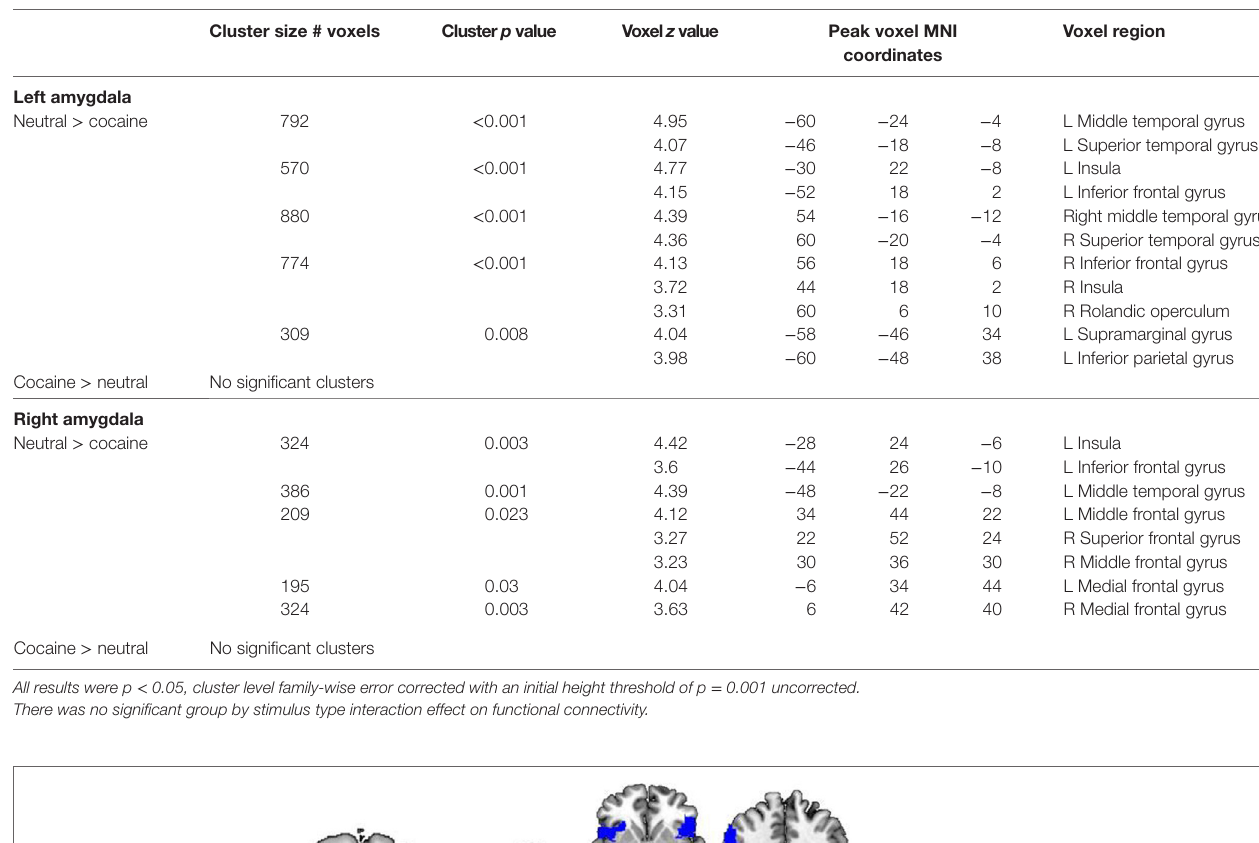
and middle temporal cortex. No such effects were evident for functional connectivity with the right amygdala as a seed region ( Table 4 ; Figure 3 ). The Relation between Functional Connectivity and a Childhood Trauma by State Anxiety Interaction There was no significant group by stimulus type by CTQ by STAI- state interaction